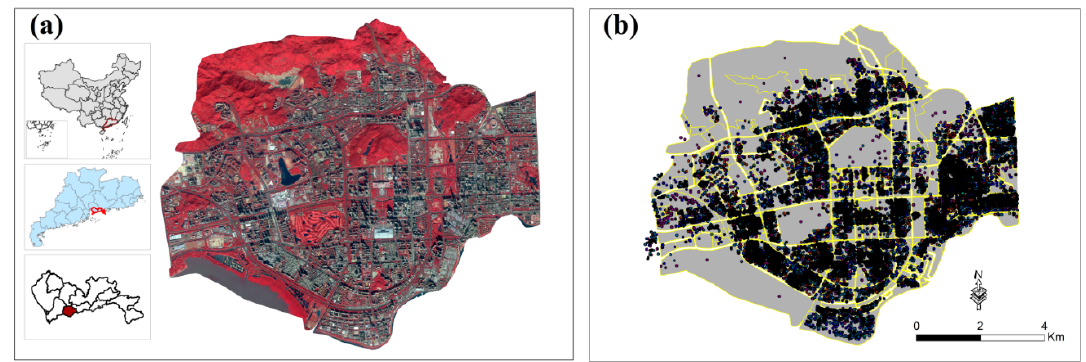
Figure 2. Location of Futian District and remote sensing image. ( a ) Remote sensing image. ( b ) Road network data and point of interests (POIs).